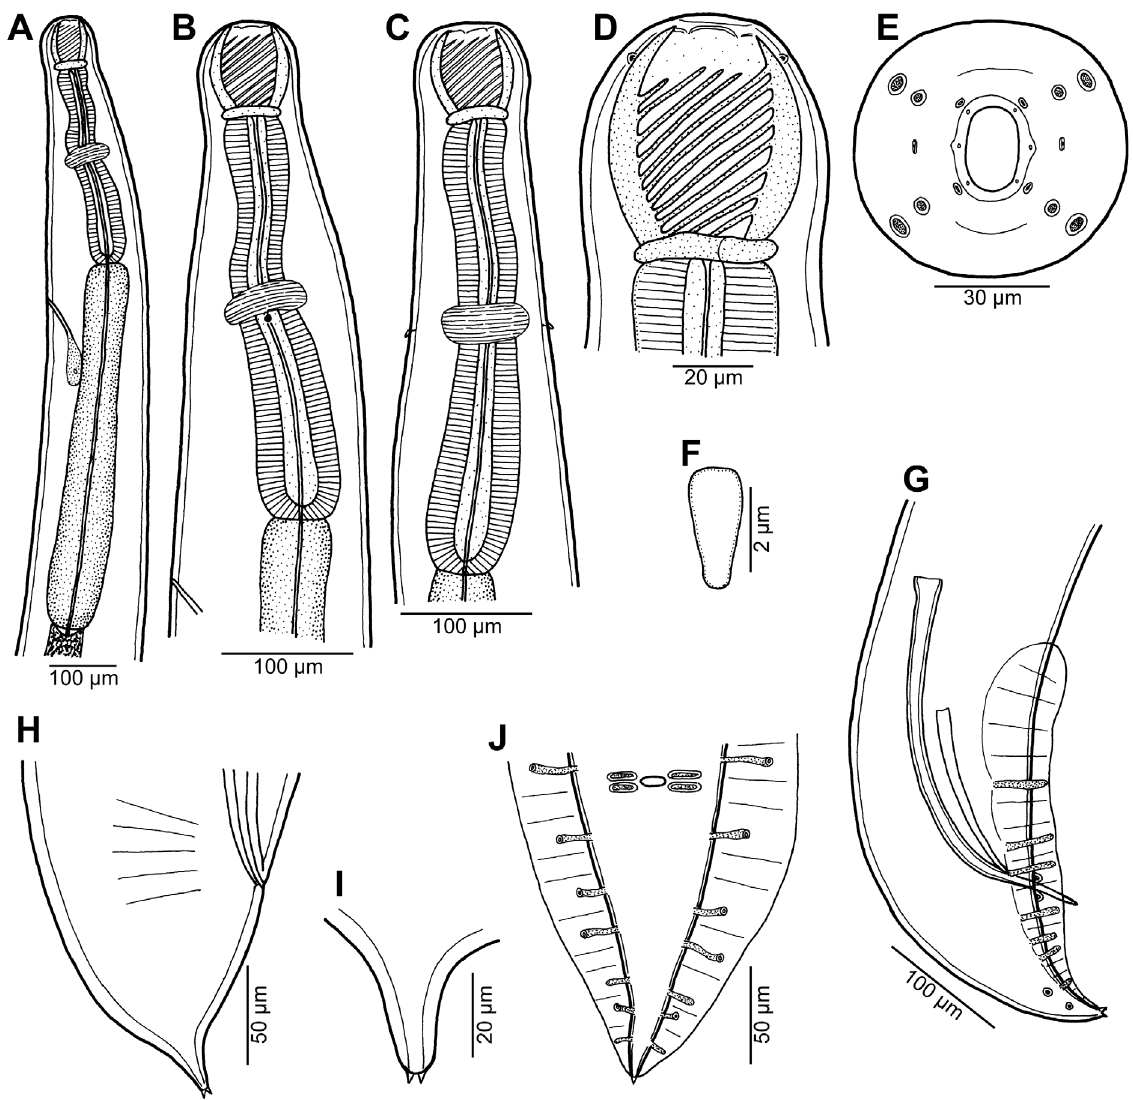
Figure 7. Procamallanus ( Spirocamallanus ) synodi n. sp. from Synodus dermatogenys . (A) Anterior end of male, lateral view; (B) same, larger magni fi cation; (C) anterior end of female, dorsoventral view; (D) buccal capsule of male, lateral view; (E) cephalic end, apical view; (F) deirid; (G) posterior end of male, lateral view; (H) tail of female, lateral view; (I) tail tip of female, lateral view; (J) tail of male, ventral